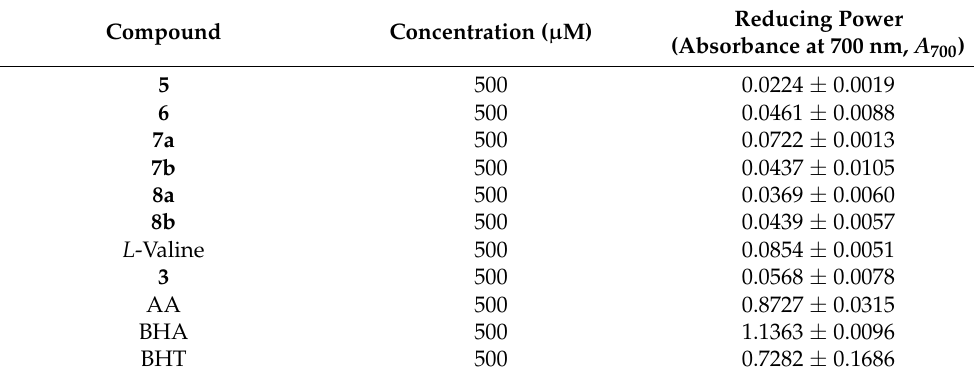
Table 8. Results of the screening of the antioxidant activity of the compounds tested by the ferric reducing power